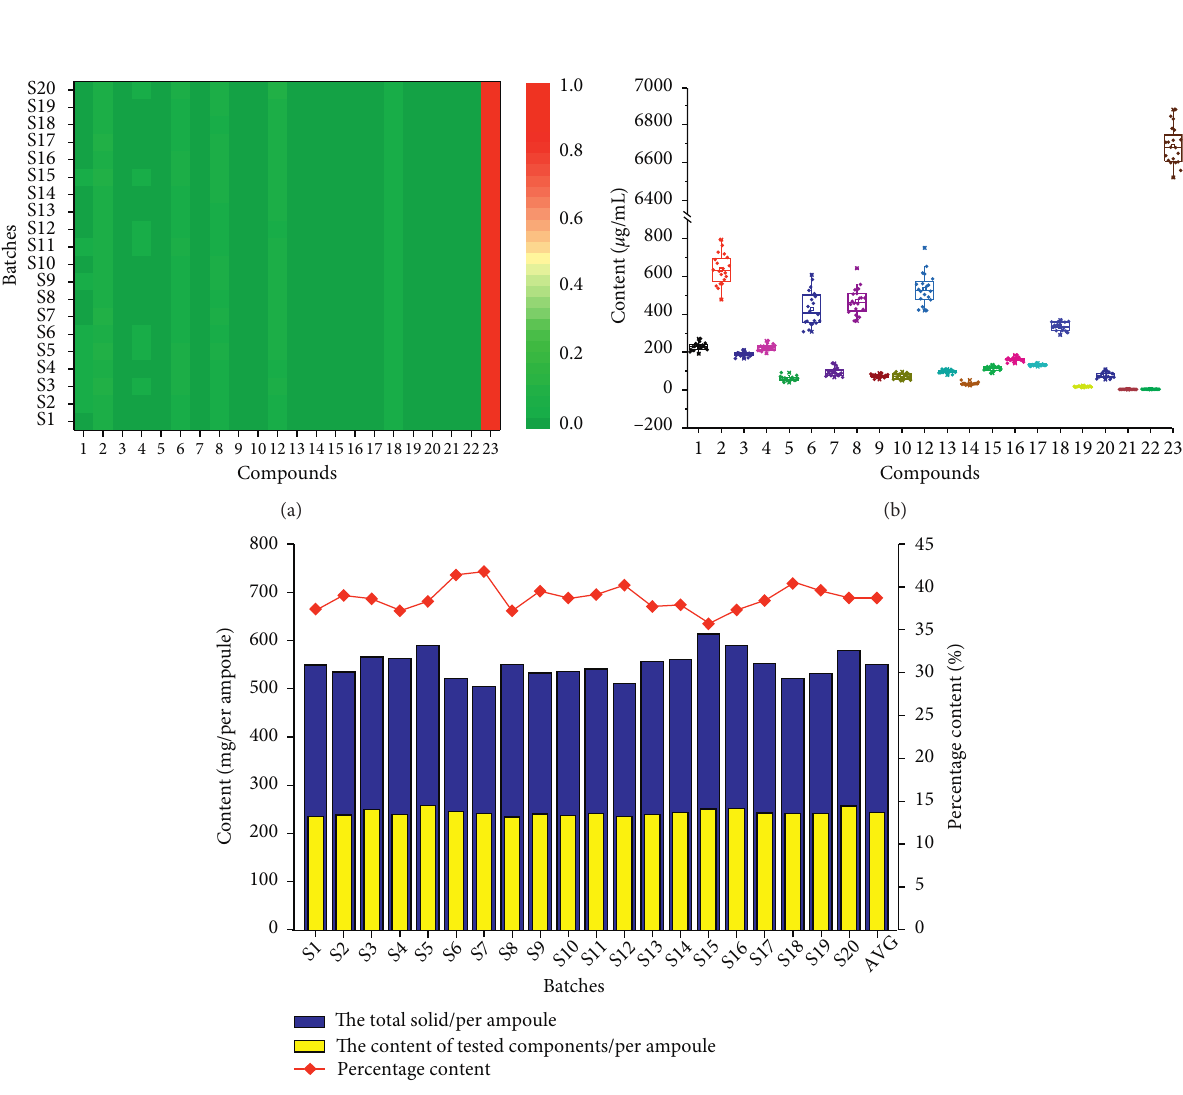
Figure 5: The heat map (a), the box-plot (b), and the bar graph (c) for the quantitative analysis of 22 targeted compounds in SHLIs of 20